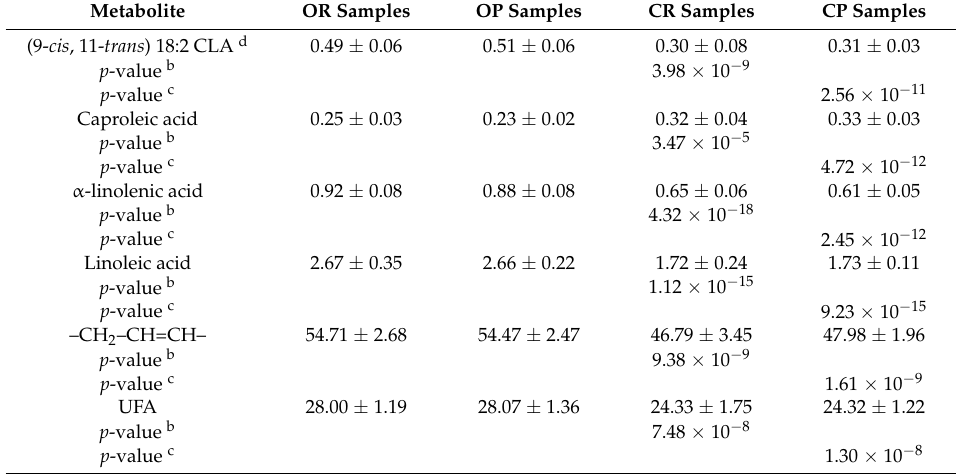
Table 1. Mean % content a of the metabolites (indicators) in the lipid fraction of milk samples. The p -value of the t -test is reported b,c